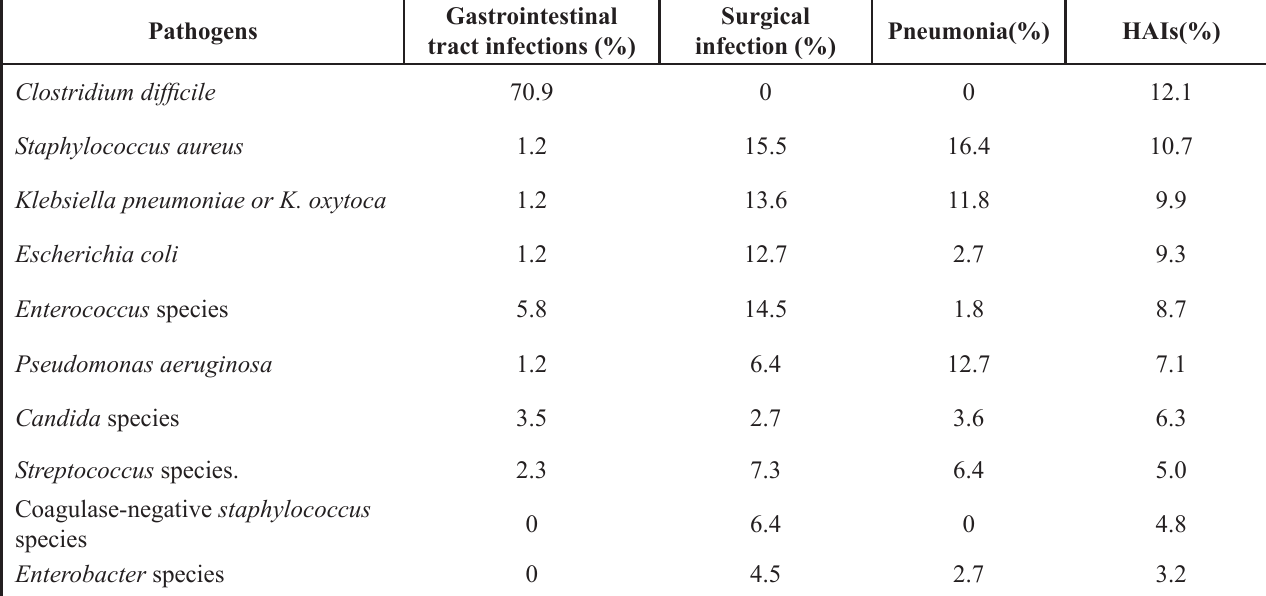
Table 1. Prevalence of pathogens causing nosocomial infections